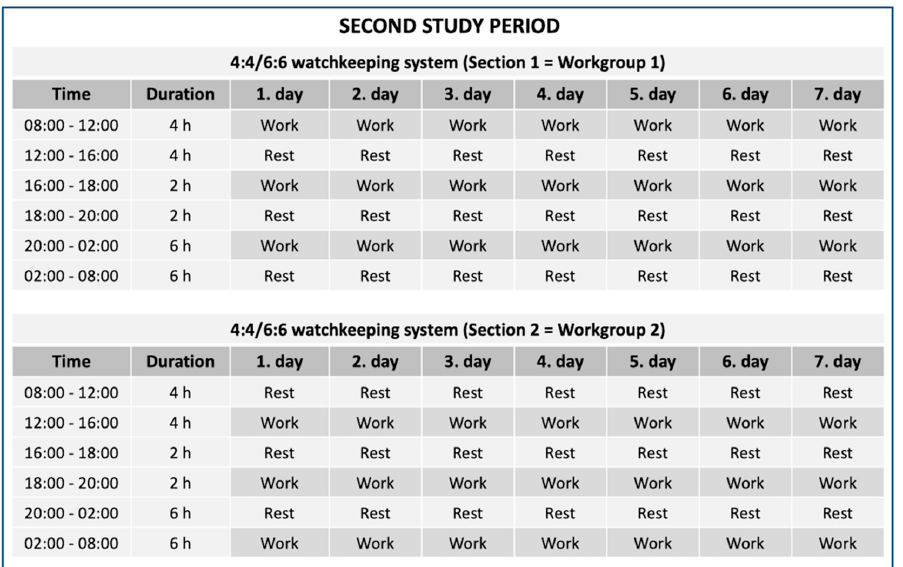
Figure 1. The structure of the two Section 4:4 watchkeeping system during the first study period.